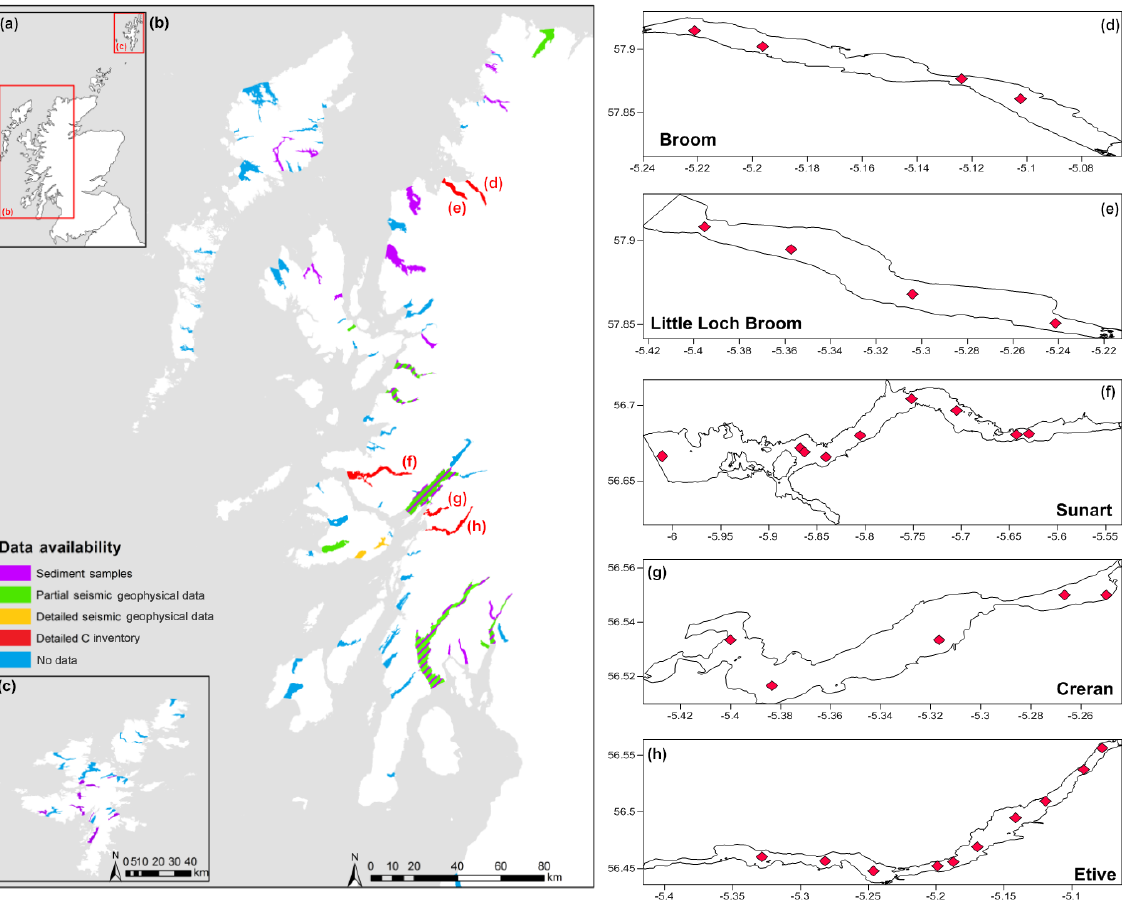
Figure 1. Map illustrating the location of Scotland’s 111 fjords and the available data. Additionally, detailed maps present the sampling locations within (d) Loch Broom, (e) Little Loch Broom, (f) Loch Sunart (Smeaton et al., 2016), (g) Loch Creran (Loh et al., 2008) and (h) Loch